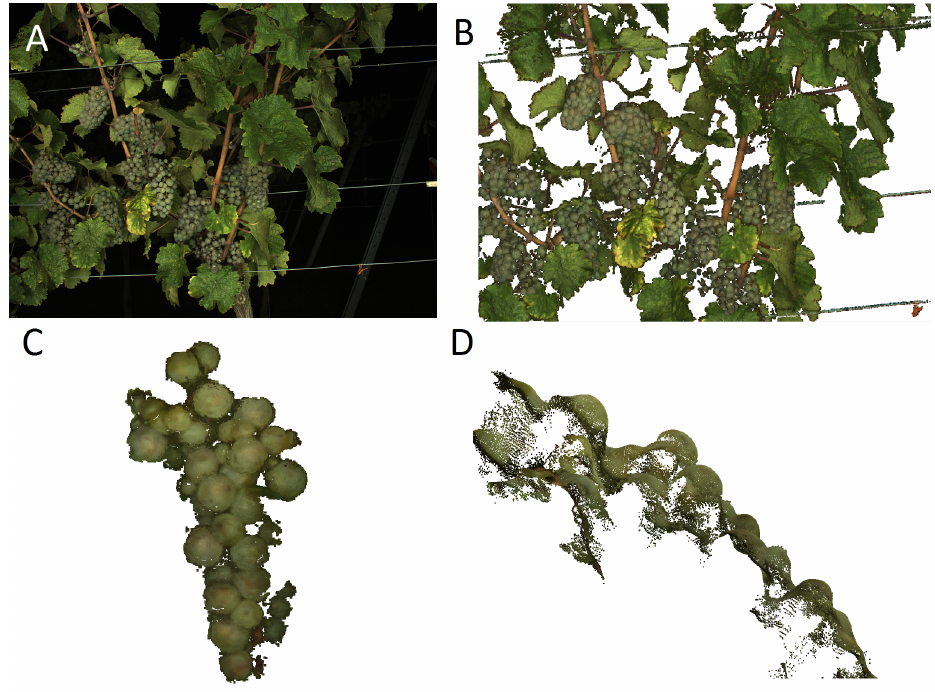
Figure 13. ( A ) Original RGB image of a VSP trellis row; ( B ) Cleaned and smoothed point cloud of the same scene; ( C ) Front view of a grape bunch; ( D ) Side view of the same grape bunch. Elevations of single berries are clearly distinguishable, forming a “valley-ridge” geometry ( B – D not yet subsampled for visualization